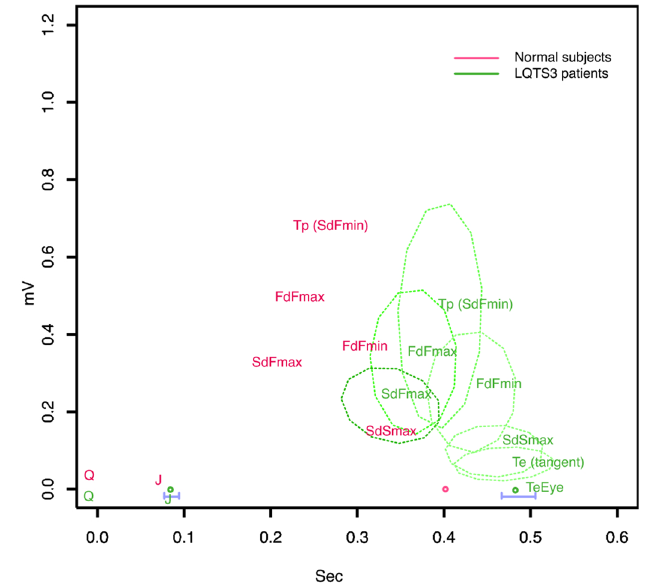
Figure 3. Simply averaged shapes of 9 landmarks of the 12 normal subjects (red) and 12 LQTS3 patients (green). Q is zero at the starting point. The x-coordinates of the landmarks were revised by Bazett correction. The abbreviations in the figure are defined in the main text of this paper. The 95% confidence intervals of the J point and TeEye are indicated by solid blue horizontal lines. The dashed ovals indicate the 95% confidence ellipses for the other landmarks. The corresponding 95% confidence ellipses for the landmarks do not overlap. The pale pink dots are the landmarks of the normal subjects, and the pale green dots are the landmarks of the LQTS3 patients. R version 4.0.2 URL https:// www.R- proje ct.